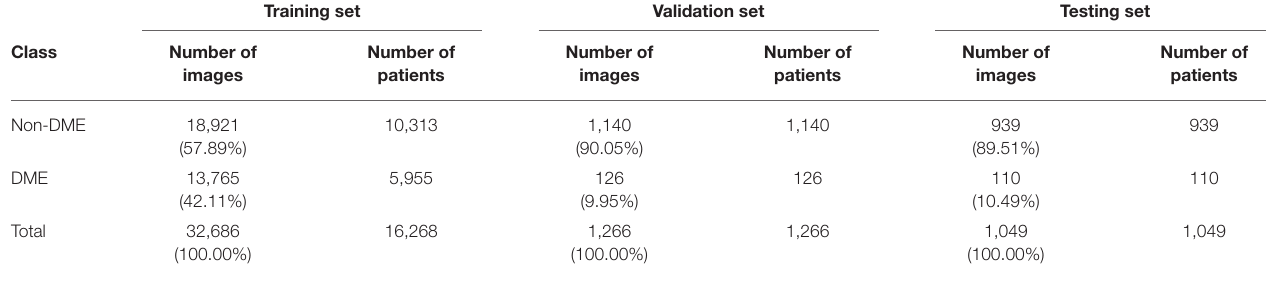
TABLE 1 | Dataset profile for the classification task in the private dataset. Training set